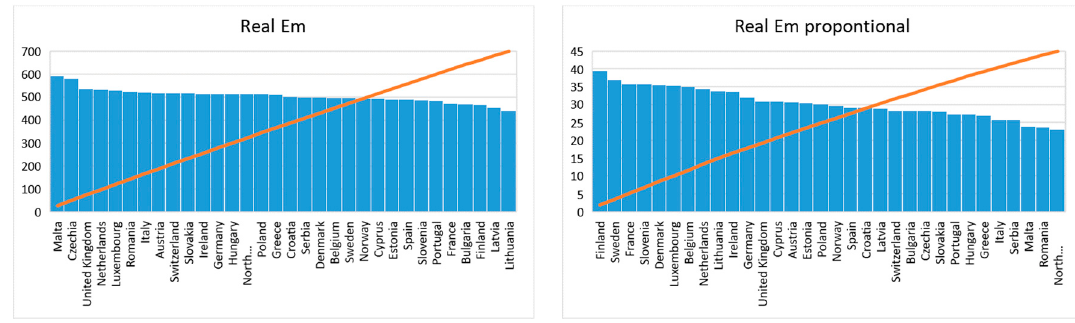
Figure 29. Compared real values, RD factors.